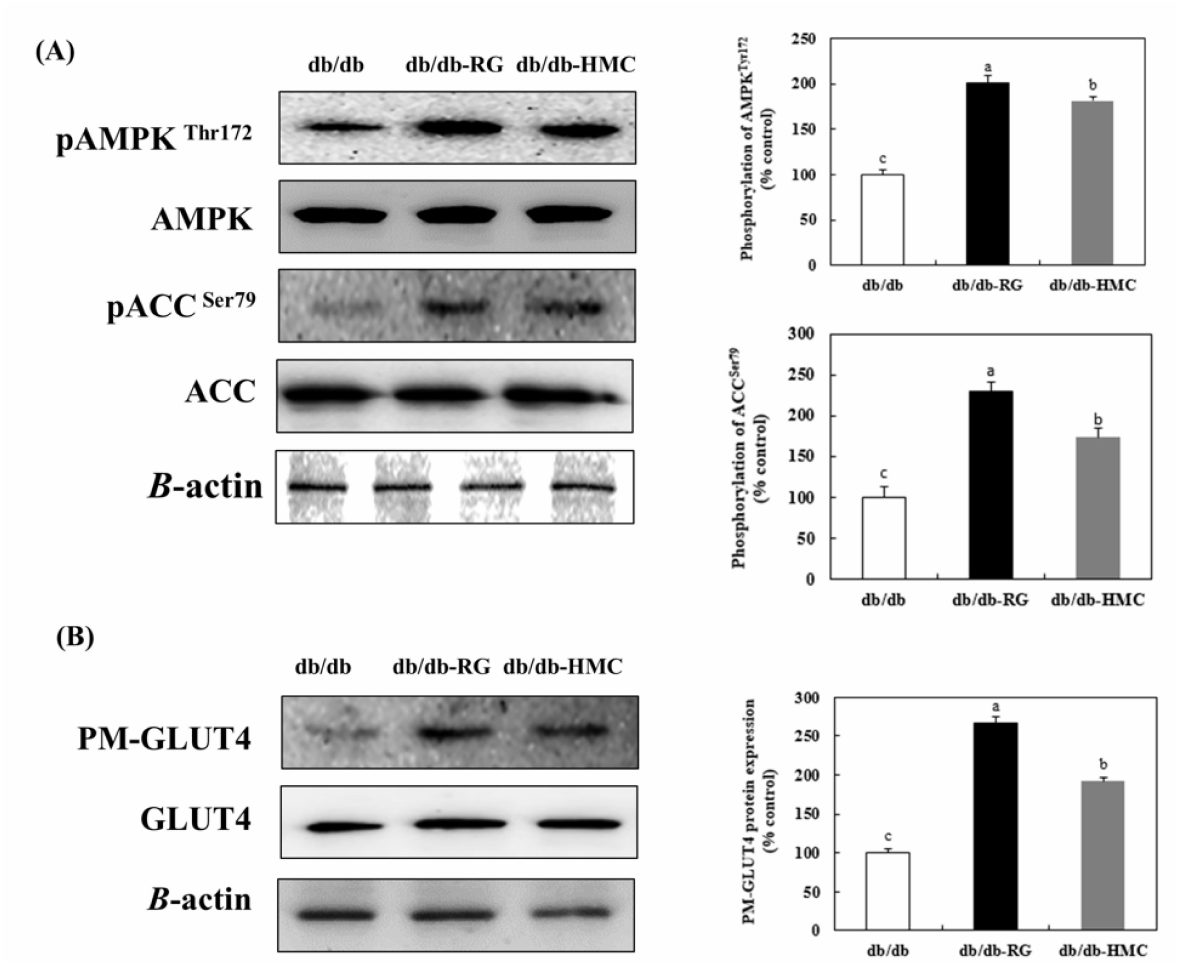
Figure 6. The effects of HMC administration on pAMPK Thr172 , pACC Ser79 and PM-GLUT4 ex- pressions in skeletal muscle of C57BL/KsJ db/db mice. ( A ) Expression of AMPK pathway and ( B ) Expression of PM-GLUT4. Mean ± SD ( n = 8). a–c The mean values that are not indicated by a common letter are significantly different among the groups ( p < 0.05) according to Duncan’s multiple range test. SD, standard deviation. db/db, db/db-RG (5 mg/kg BW per day) and db/db-HMC group (30 mg/kg BW per